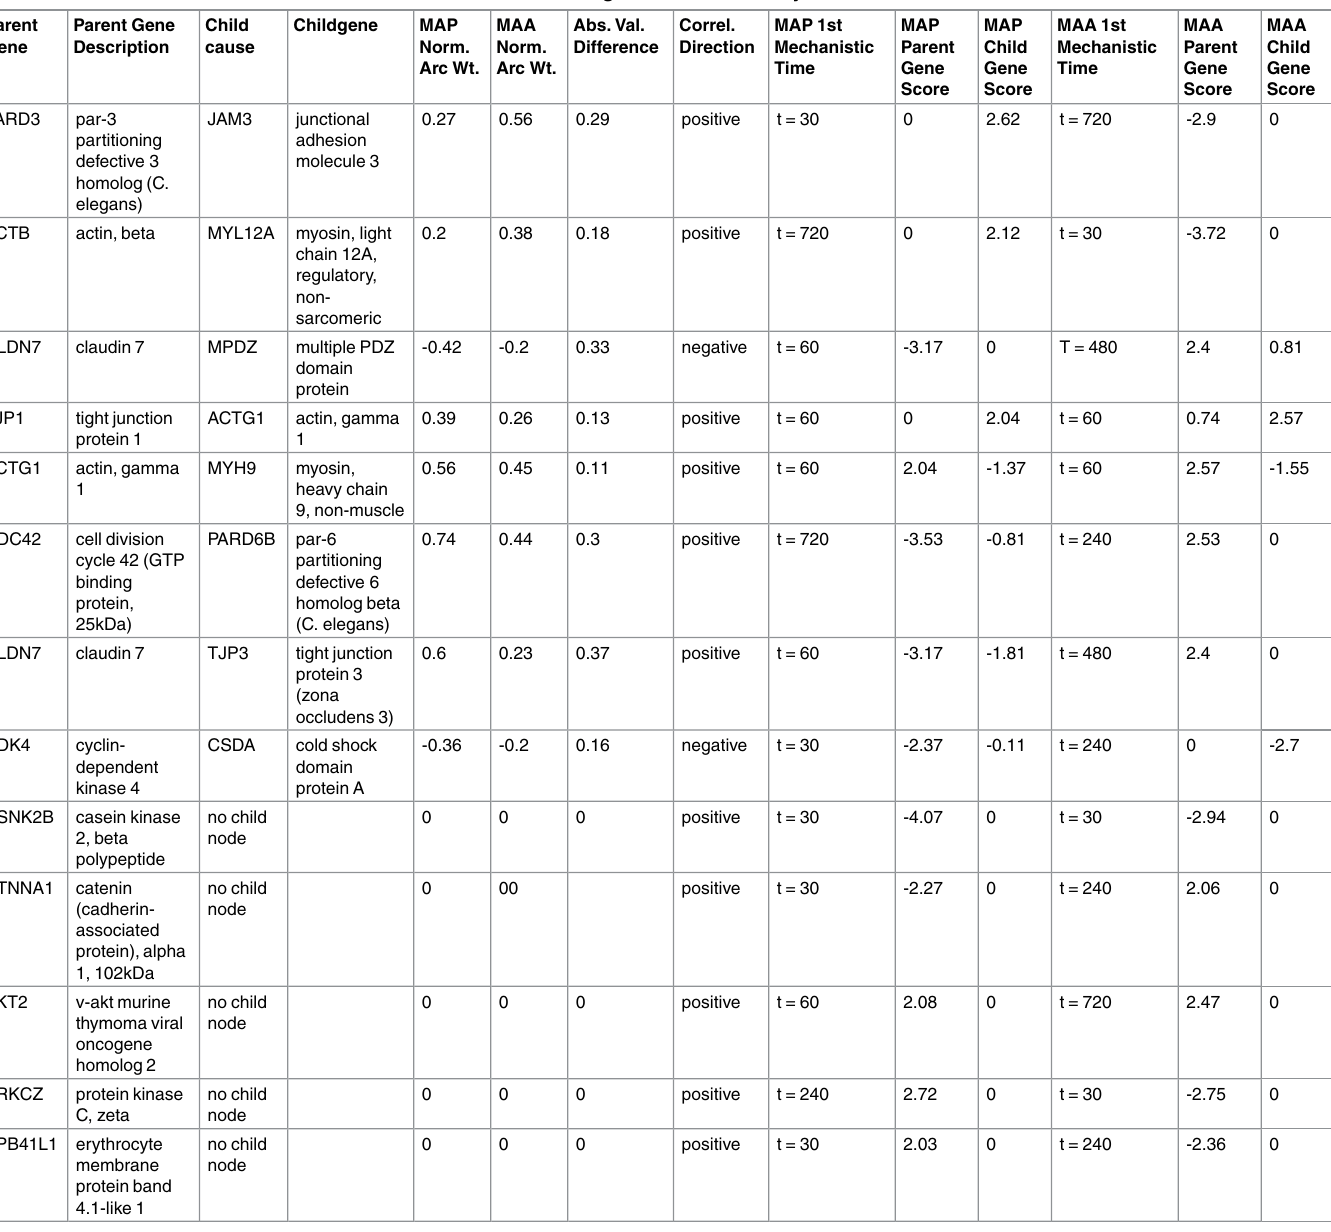
Table 4. CommonMAP and MAA Arcs and Mechanistic Genesin TightJunctionPathway. Parent Parent Gene Gene Description